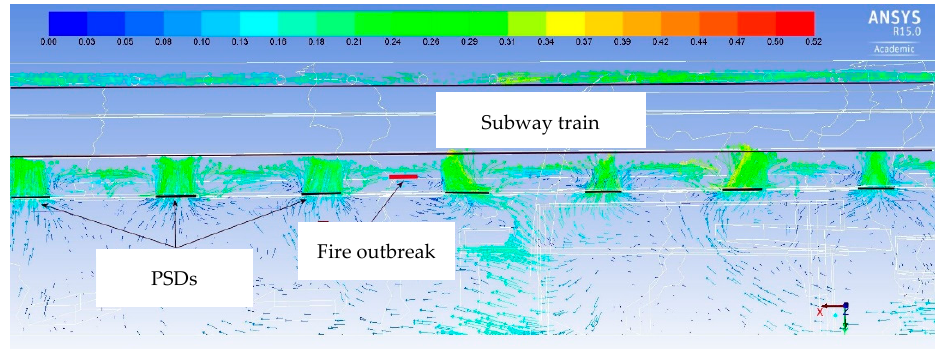
Figure 24. Air velocity vectors (m/s)—longitudinal section at the top of the PSD system (minute 20).